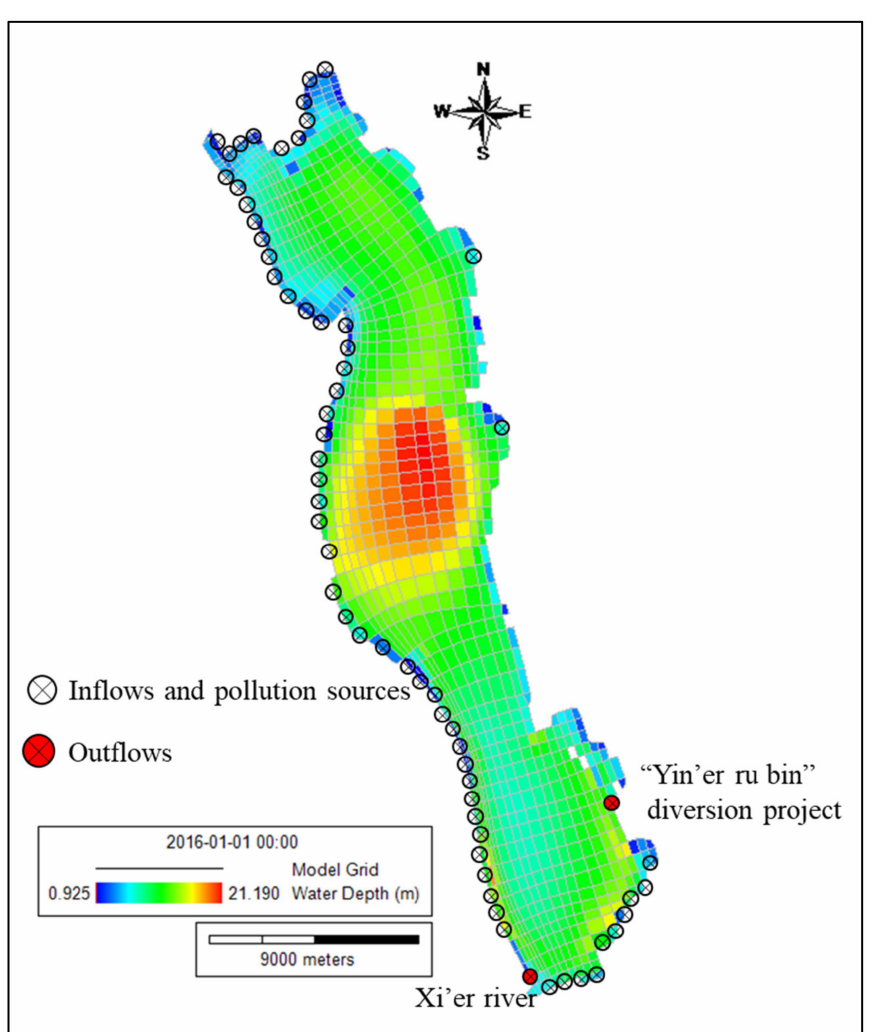
Figure 2. Diagram of computational grids of hydrodynamic water quality simulation in Lake Erhai: the distribution of 29 major rivers and streams; simplified agricultural ditches are represented with circle and x mark; 2 outflows are represented with red filled circle and x